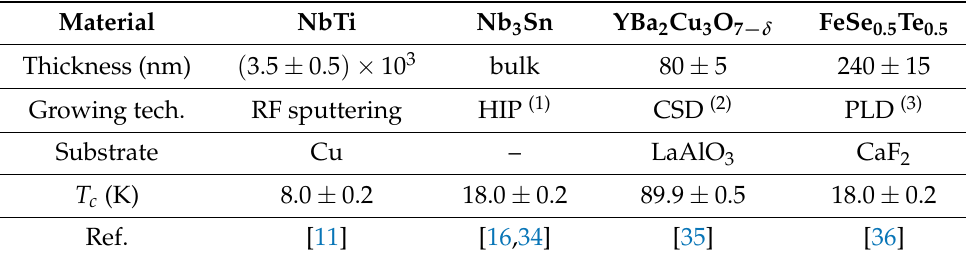
Table 1. List of the samples under